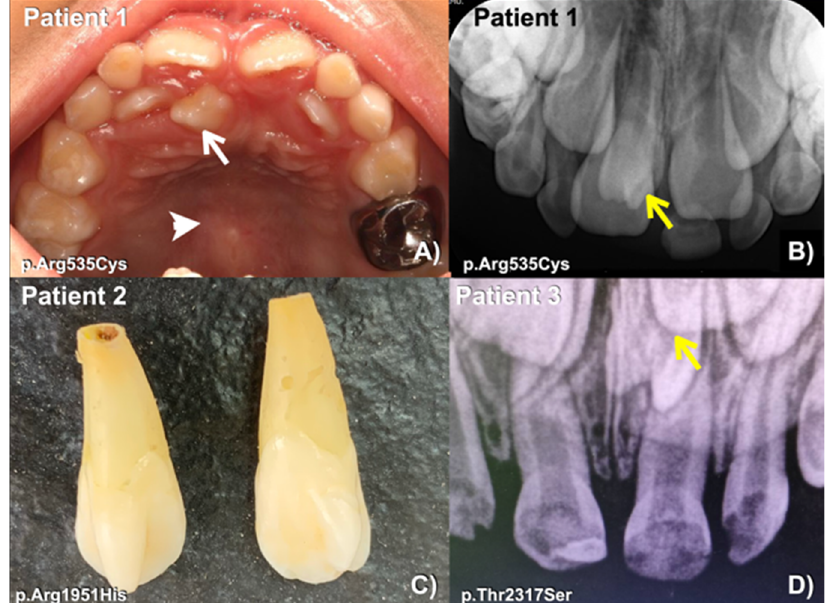
Figure 2. ( A ) Patient 1. Mesiodens (arrow). Torus palatinus (arrowhead). ( B ) Patient 1. Periapical radiograph showing an unerupted mesiodens (arrow). ( C ) Patient 2. Extracted double mesiodens. ( D ) Patient 3. Periapical radiograph showing an unerupted mesiodens (arrow).